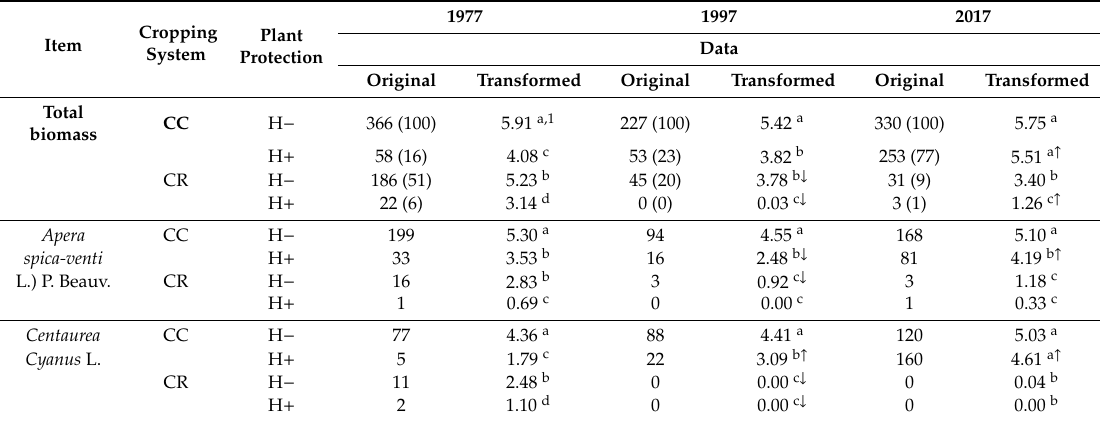
Table 5. Weed biomass (g / m 2 ) in winter rye fields (relative numbers in brackets are % of CC-H − e ff ects), including problem species